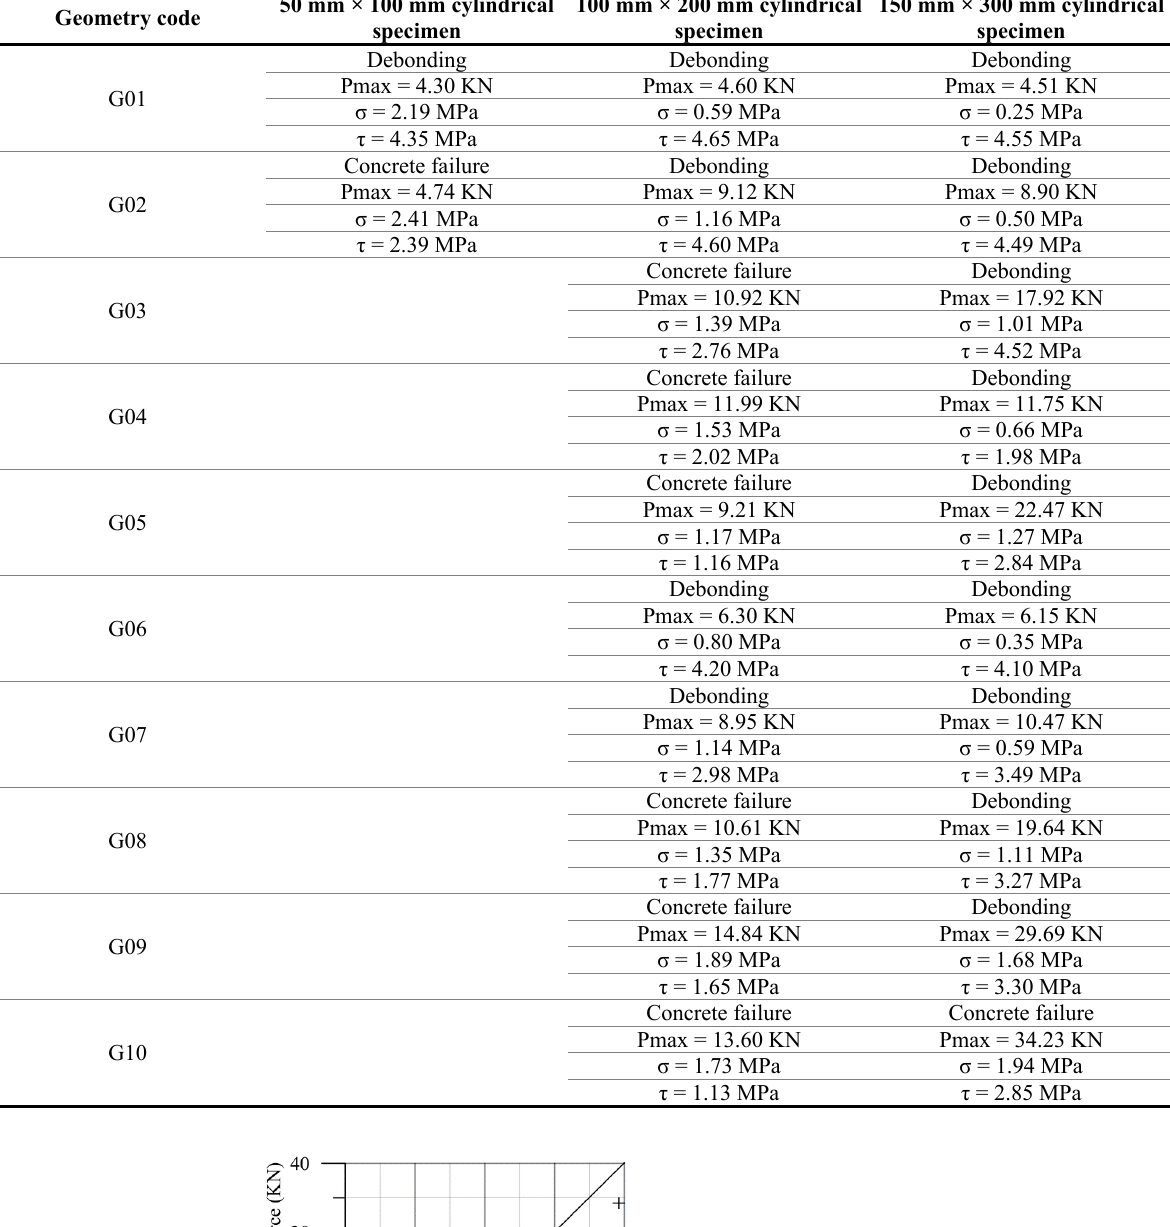
Table 3. Failure mode, maximum tensile force (Pmax), normal tensile stress on the concrete (σ), and shear stress at the interface between concrete and FRP (τ).